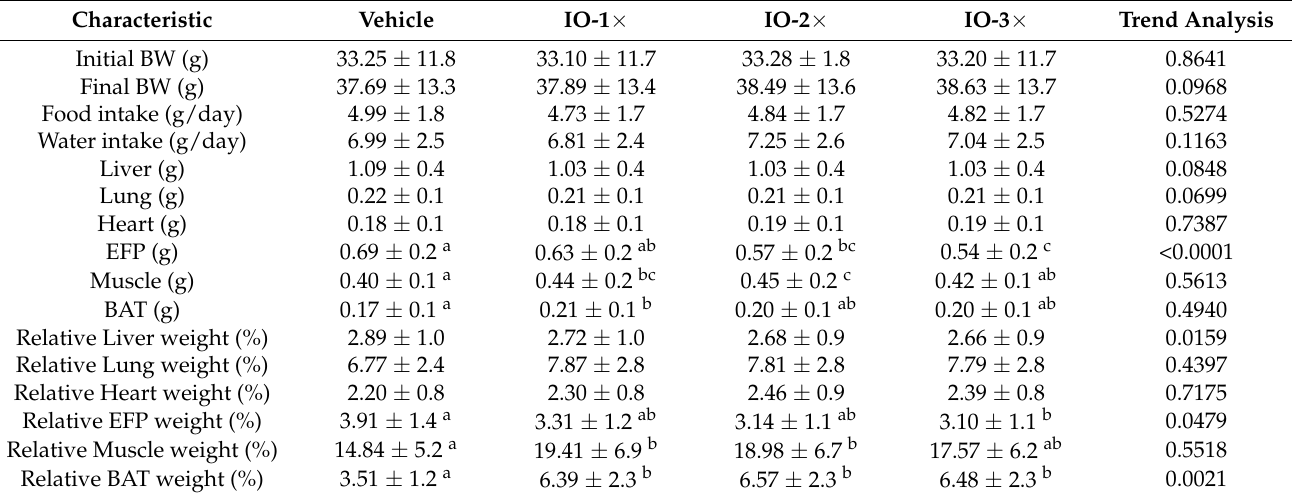
Table 1. General characteristics of mice with IO supplementation.